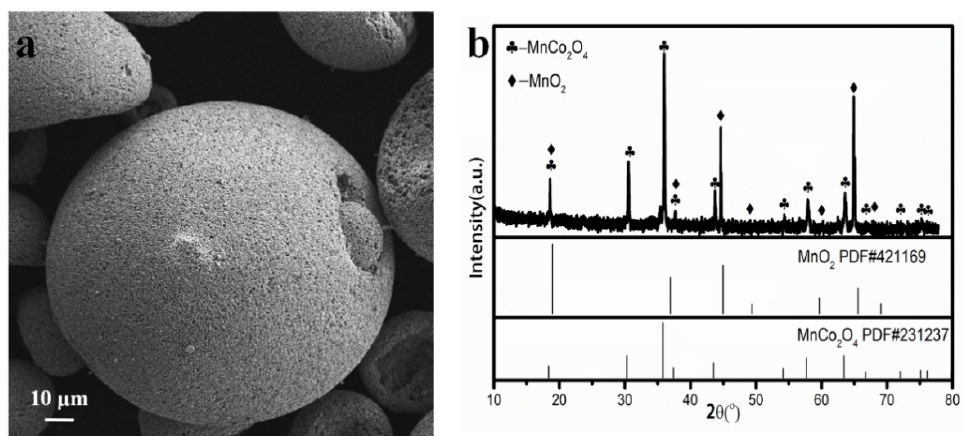
Figure 3. ( a ) surface morphology, ( b )XRD pattern of CoMnO oxide powder.